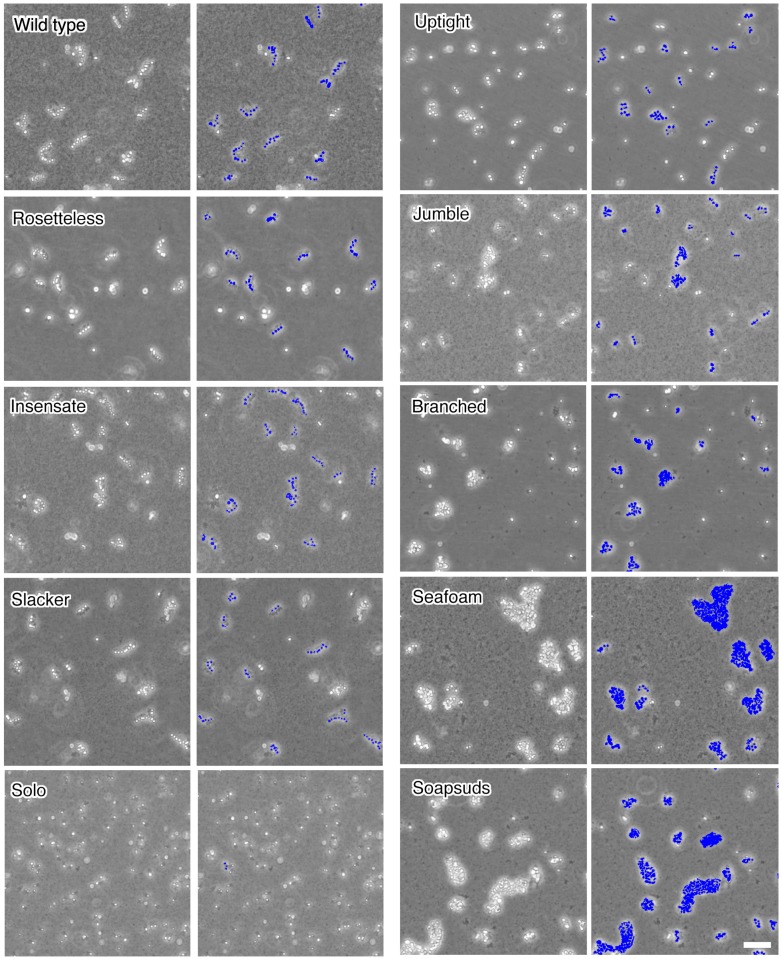
Chain colony morphologies of diverse mutants.S. rosetta chain colonies from wild-type and mutant cultures grown without exposure to A. machipongonensis signals are shown at low magnification to document the morphologies of numerous chain colonies. Each phase-bright circle is a choanoflagellate cell, while the dark specks are bacteria. To the right of each image, the cells of each in focus chain colony have been false colored blue to identify chains and emphasize chain morphology. Three mutants (Rosetteless, Insensate, and Slacker) exhibit essentially wild-type chains. Solo is largely single-celled and rarely forms chains. The five remaining mutants all form chains that are more branched or highly clustered than wild-type chains. Scale bar = 50 µm.